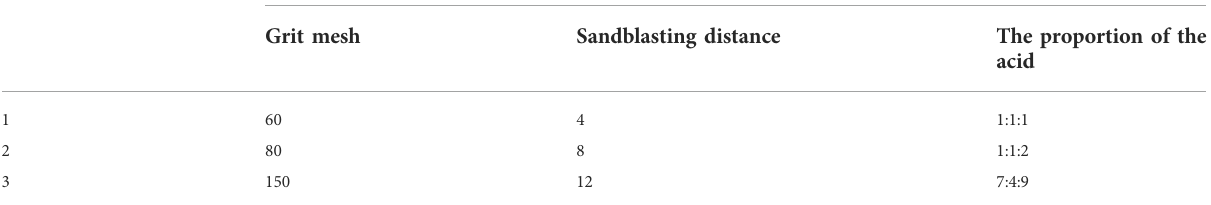
TABLE 1 Orthogonal experimental